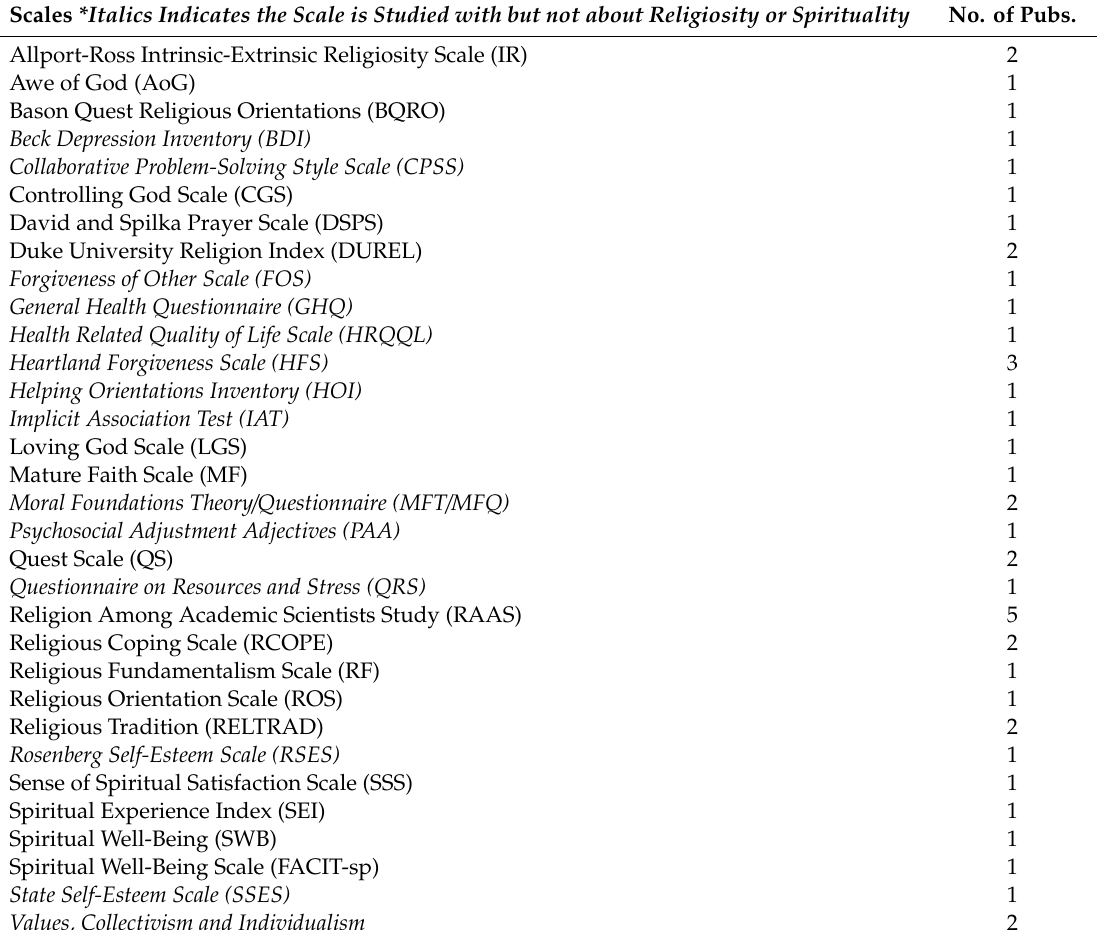
Table A1. Scales, indexes, and inventories in reviewed publications by frequency. Scales *Italics Indicates the Scale is Studied with but not about Religiosity or Spirituality No. of Pubs.